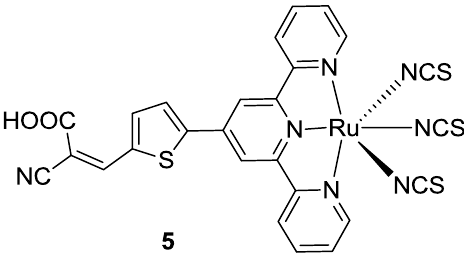
Figure 7. Terpyridine with a cyanoacrylic acid moiety [76].